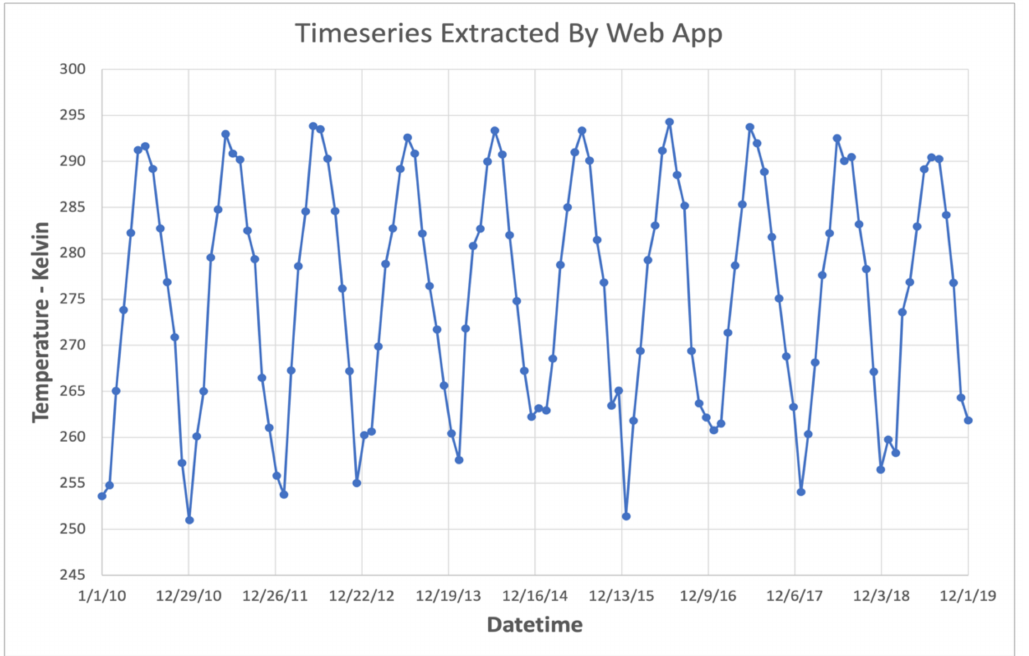
Figure 10. Air Temperature Series Extracted via Web